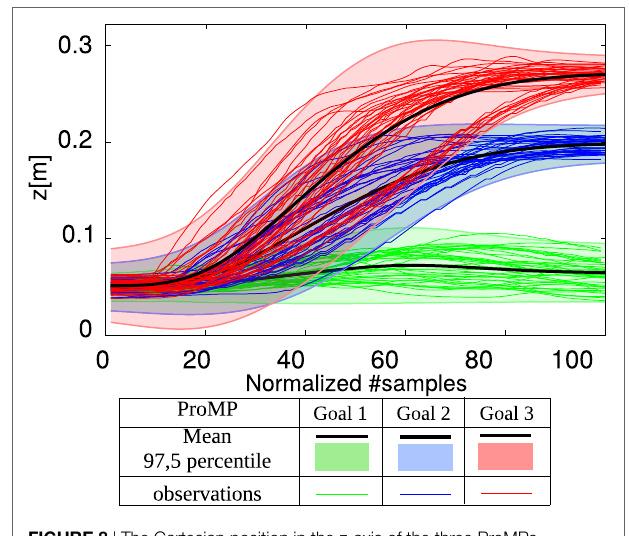
FIGURE 8 | The Cartesian position in the z -axis of the three ProMPs corresponding to reaching three targets. There are 39 trajectory demonstrations per each ProMPs with M = 5 basis functions, and (cid:22) s = c = 1 M ; h = 1 M 2